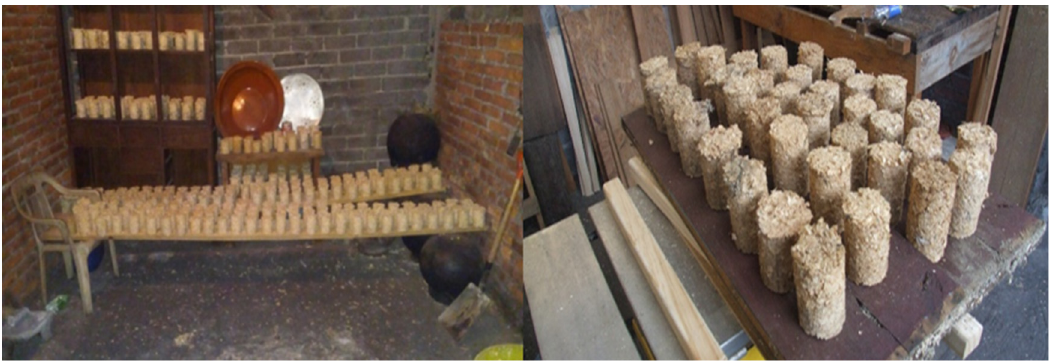
Figure 8. Images of the finished briquettes.